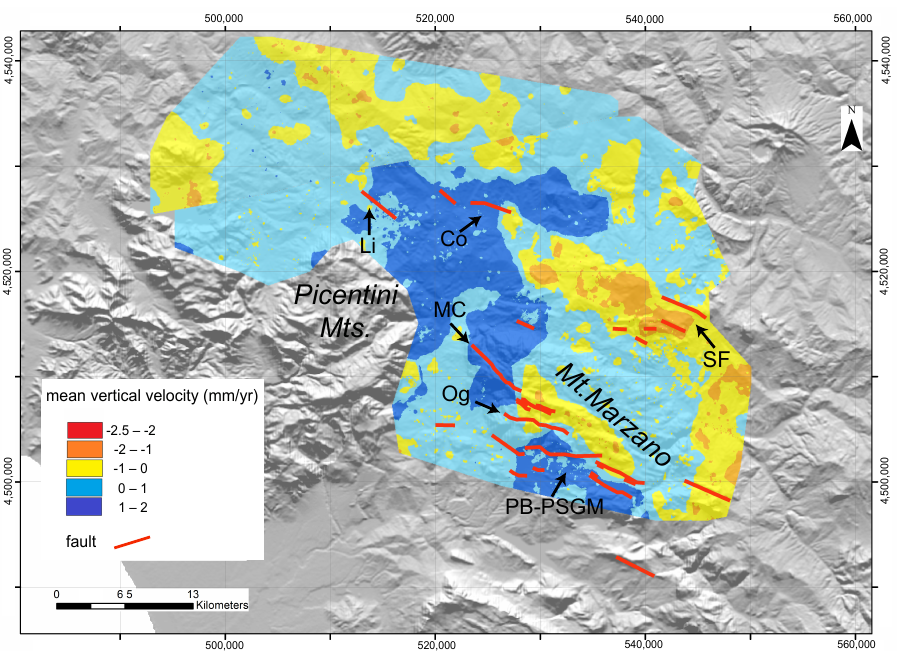
Figure 10. ERS data: Vertical mean velocity / ground deformation map 1992–2000, IDW interpolation (cell size 50 × 50 m). Data statistical selection with the Cluster and Outlier Analysis , i.e., map constructed using the ERS subsets labelled ‘CO_2k_IDW_nout’ (which includes only PS classified as HH and LL). Fault / fault array labelling as in Figure 2b.